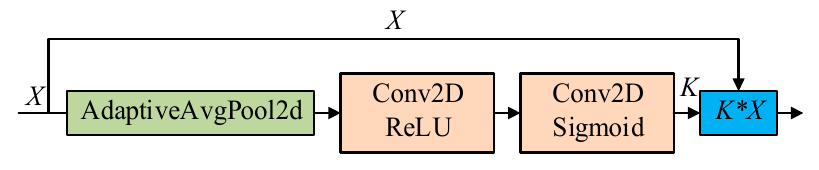
Figure 2. Se_Block Attention Module. To increase the feature extraction capability of SSD feature extraction model and focus more on the feature layers with higher importance, this paper adds Se_Block attention mechanism module in front of the last six effective feature layers used for regression prediction on the basis of SSD model. The feature layers are rescaled by channel dimension. The structure of Se_SSD network is shown in Figure